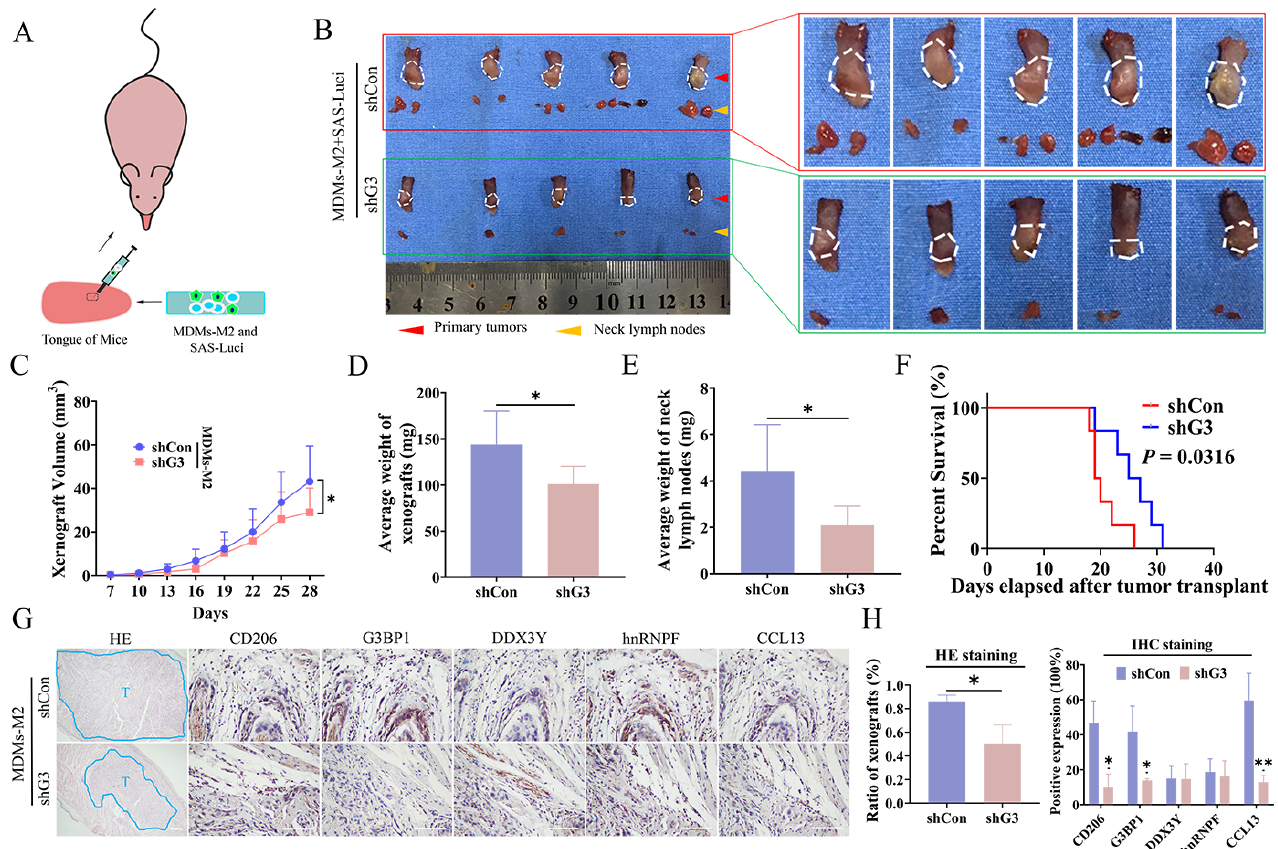
Figure 6. CCL13 regulated by SG formation in M2 TAMs promoted OSCC metastasis in vivo. ( A ) The schematic diagram of orthotopic metastasis model in BALB/c nude mice. SAS cells stably expressing the luciferase and mixed with MDMs-M2 transfected with control or G3BP1 shRNA were injected into the tongue of mice. ( B ) The sizes of primary tumor or neck lymph nodes on 28 days after tumor injection in control or G3BP1-depleted group. The enlarged pictures were also inserted at the right side. ( C ) Xenograft growth statistics on 28 days after tumor injection in control or G3BP1-depleted group. ( D ) The average weight of transplanted tumors in control or G3BP1-depleted group. ( E ) The mean weight of lymph nodes in control or G3BP1-depleted group. ( F ) Kaplan–Meier survival curves were used to assess the overall survival rate of mice ( n = 6) with tumors, and a log-rank test was used to calculate the statistical significance. ( G ) Representative images of IHC staining showed lower expression of CCL13 and CD206 in G3BP1-depleted group than control group. Scale bar, 30 µ m. H&E staining of xenografts was used to assess the tumor sizes of the two groups. The areas marked by blue circles were the xenograft in mice tongues. T, Tumor. Scale bar, 100 µ m. ( H ) The statistical results of IHC and H&E staining images were shown via the bar graphs. (*, p < 0.05 and **, p <